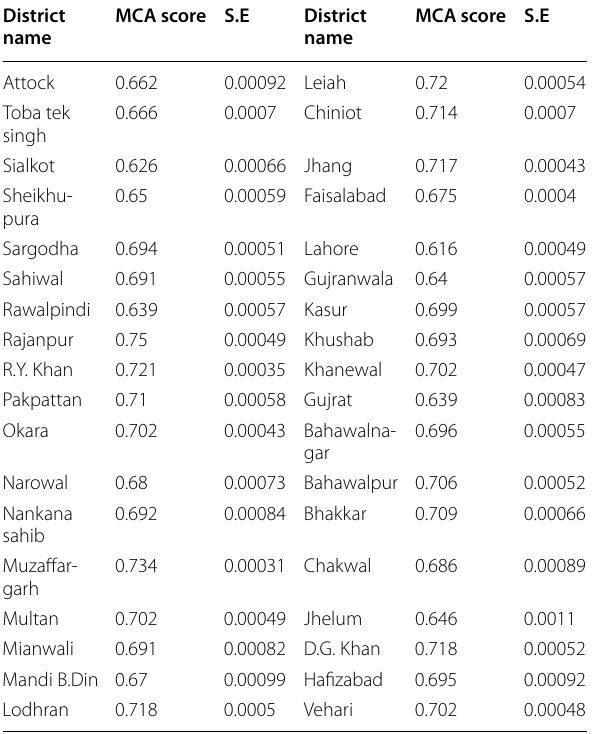
Table 5 Asset-based poverty index for districts of Punjab. Source